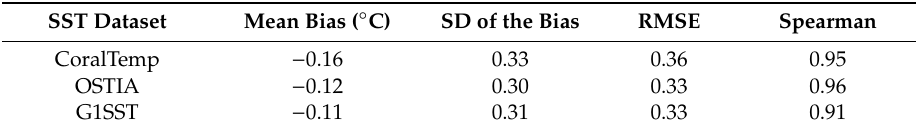
Table 7. Mean bias (satellite—in situ), standard deviation of the bias, root mean square error (RMSE) of the bias, and Spearman correlations between satellite-based SST datasets and averaged in situ temperature for San Cristobal from 1 March 2019–1 March 2020 (one year) for CoralTemp, and OSTIA